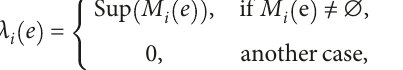
Figure 3: Graphic view of the Total e , β